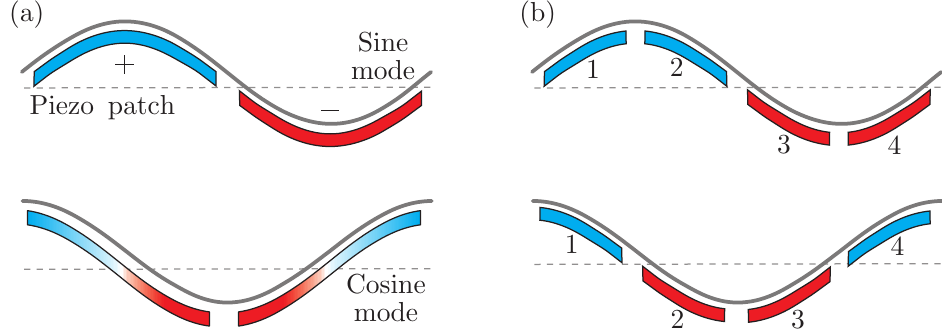
Figure 3. PZT patches laid with ( a ) two patches per nodal diameter; ( b ) four patches per nodal diameter. The colors indicate the sign of the curvature. In the configuration with four patches per nodal diameter, the patches numbered 1 and 3 have curvatures of opposite signs for both the sine and cosine modes, and similarly for the patches numbered 2 and